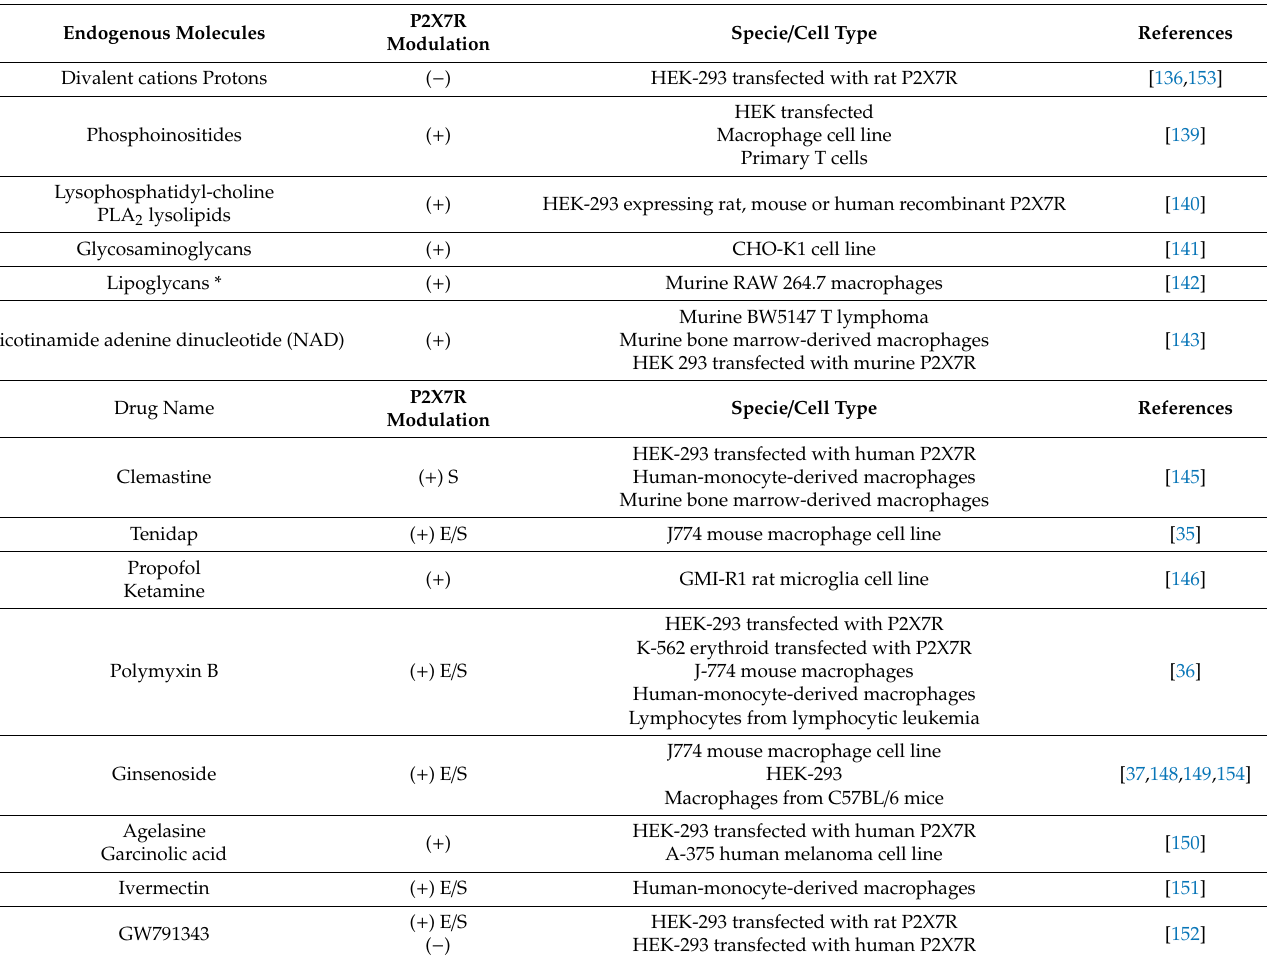
Table 1. Endogenous and pharmacological molecules that modulate P2X7 receptor activation in di ff erent species and cell